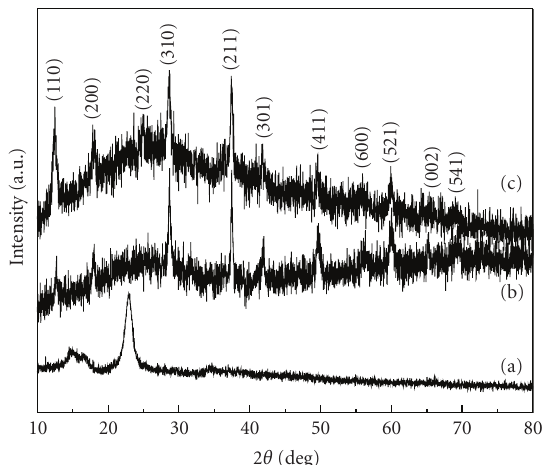
Figure 1: XRD patterns of the precursor/cotton of sample 1 (a), sample 1 (b), and sample 3